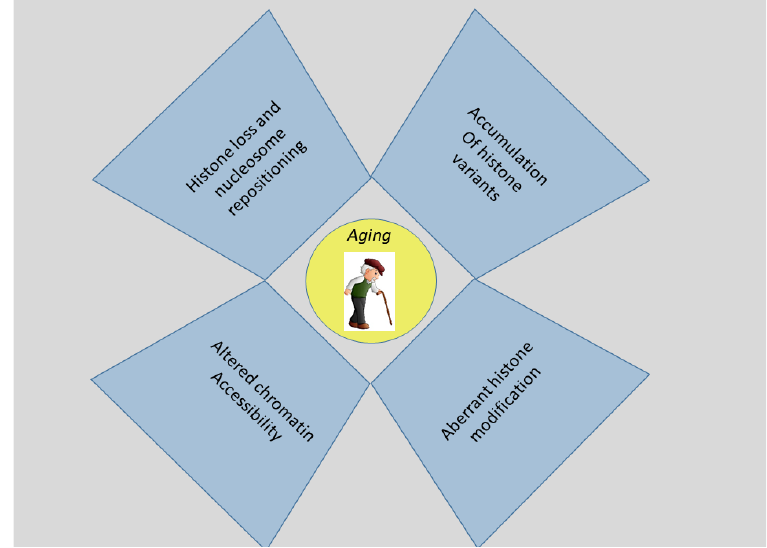
Figure 1. Epigenetic changes in relation to age. The incorporation of different histone variants, altered histone modification and aberrant DNA methylation patterns entail an abnormal chromatin state with the intervention of chromatin modifiers. This abnormal epigenetic scenario induces altered transcriptional patterns and a transcriptional drift within the population.